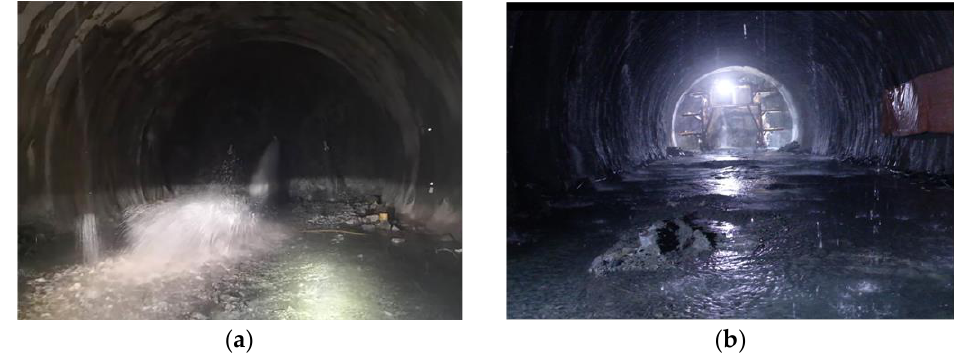
Figure 3. Water gushing at the tunnel face. ( a ) Tunnel face; ( b ) the vicinity of tunnel face.